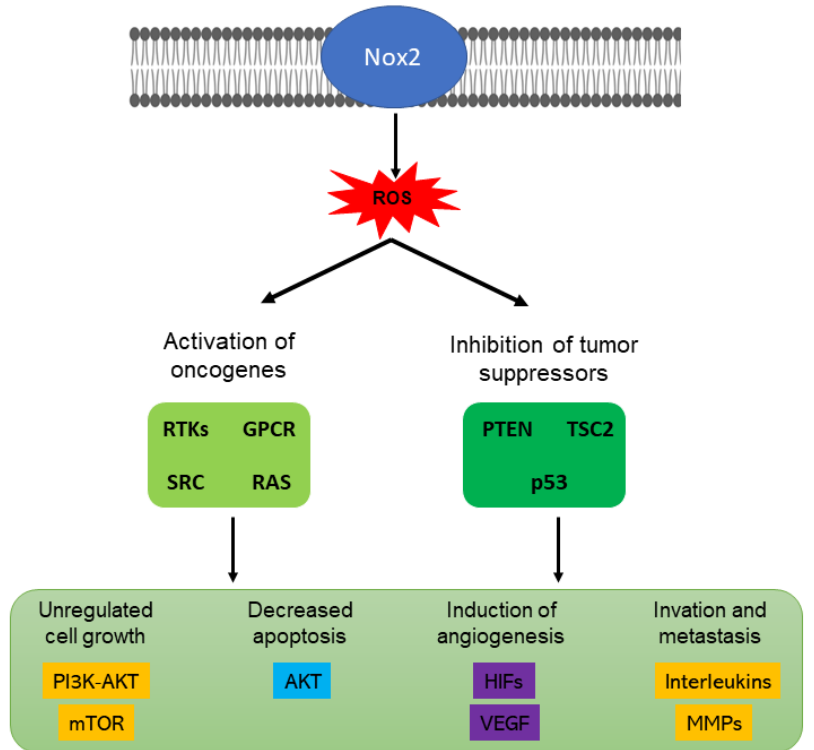
Figure 4. Signaling pathways possibly activated and inhibited by NOX2. Oncogene activation in- cludes receptor tyrosine kinase (RTK), G protein-coupled receptors (GPCR), proto-oncogene tyrosine-protein kinase (SRC), and serine-threonine kinase (RAS). ROS inhibit tumor suppressors such as dual lipid tyrosine phosphatase (PTEN), tuberous sclerosis complex 2 (TSC2), and the p53 gene. All of these can affect different pathways to a greater or lesser extent, such as cell growth, decreased apoptosis, activation of angiogenesis, and invasion and metastasis. Other abbreviations: phosphoinositol 3-kinase (PI3K), target of rapamycin (mTOR), hypoxia-inducible factors (HIF), vascular endothelial growth factor (VEGF), and matrix metalloproteinases (MMPs). Modified from